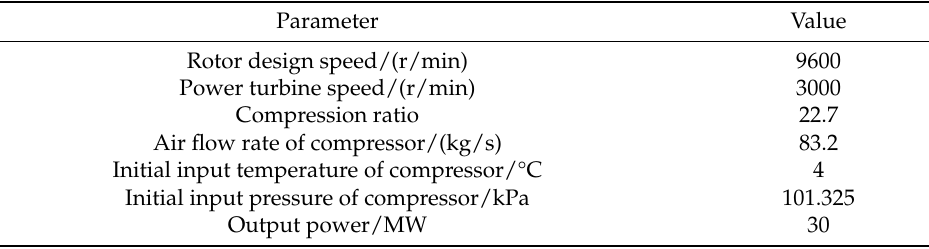
Table 1. Related parameters of the aero-derivative gas turbine.